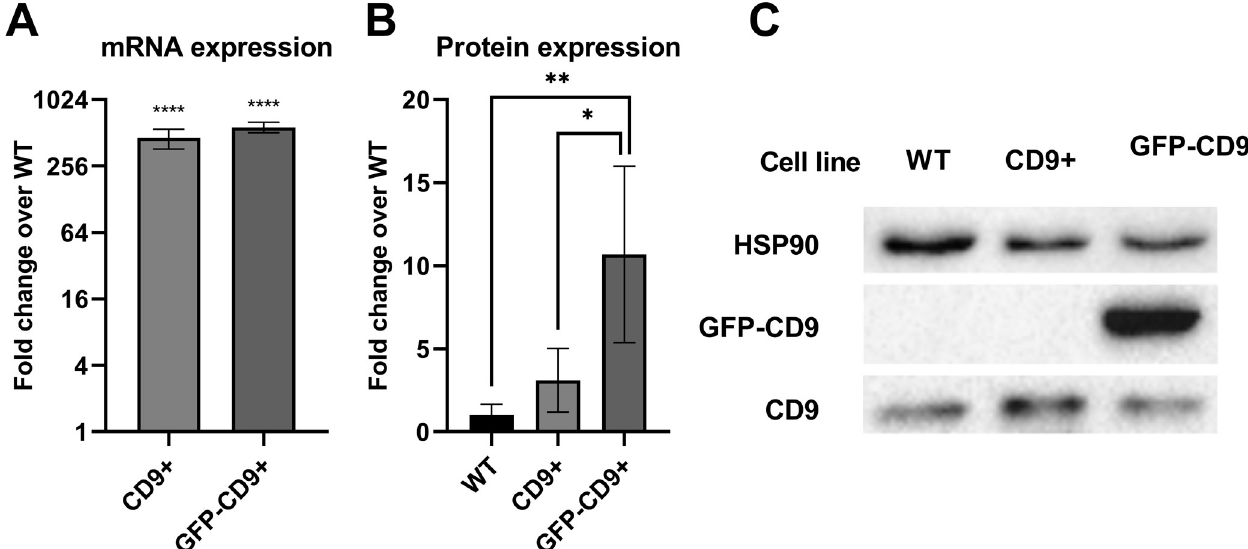
Fig 1. Change of CD9 expression in CD9+ and GFP-CD9+ lines. (A) Expression of CD9 mRNA was estimated by qPCR. Fold change data are represented as mean ± s.d. in log 2 scale (n = 3 for each line). (B) CD9 protein expression was estimated by WB. Band intensity was normalized over the loading control HSP90. All data were normalized over the average of the WT group and are shown as mean ± s.d. (n = 4 for each cell line). (C) Example of WB membrane stained for CD9 and HSP90 as loading control. Note that samples from the GFP-CD9+ cell line present 2 bands when anti-CD9 antibody is used: one band correspond to the endogenous protein, the other to the fusion GFP-CD9 protein. � = p � 0.05; �� = p � 0.01; ���� = p � 0.0001.